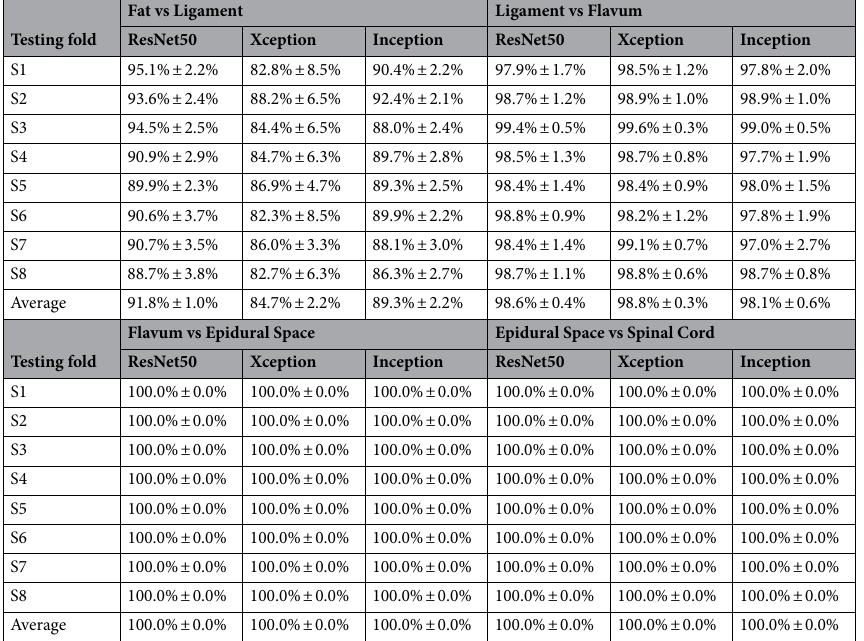
Epidural Space vs Spinal Cord